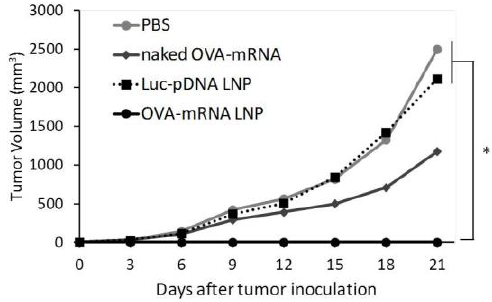
Figure 3. Prophylactic anti-tumor effect. C57BL/6J mice were treated with PBS, naked OVA-encoding mRNA (naked OVA-mRNA), LNP encapsulating luciferase-encoding pDNA (Luc-pDNA LNP), and LNP encapsulating OVA-encoding mRNA (OVA-mRNA LNP) at 7 days before tumor inoculation. The mice were inoculated with E.G7-OVA cells and tumor volume was monitored. The plots represent the mean +/ − SEM (total of 5 mice/group, * p < 0.05, Tukey-Kramer test).